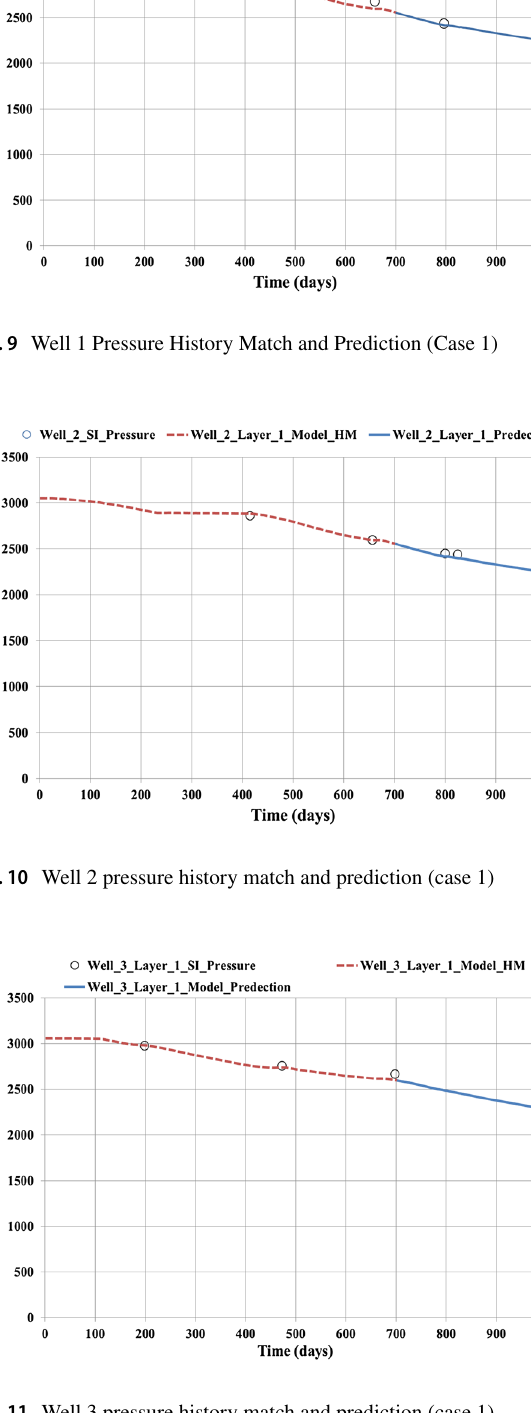
Fig. 11 Well 3 pressure history match and prediction (case 1)